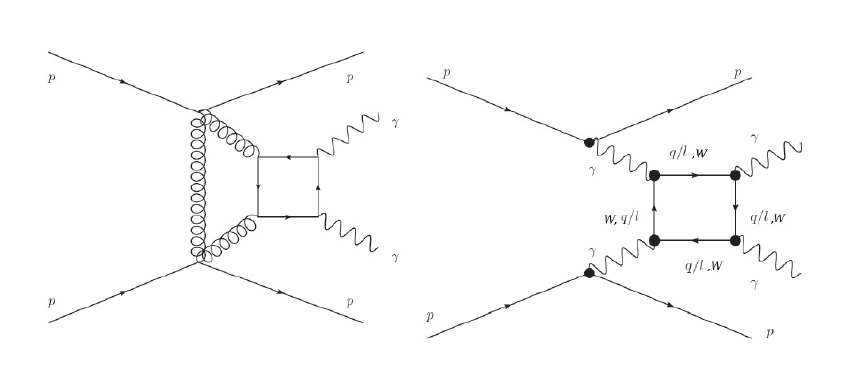
Figure 2: Exlusive production of diphoton vis QCD processes (left) and QED photon exchanges